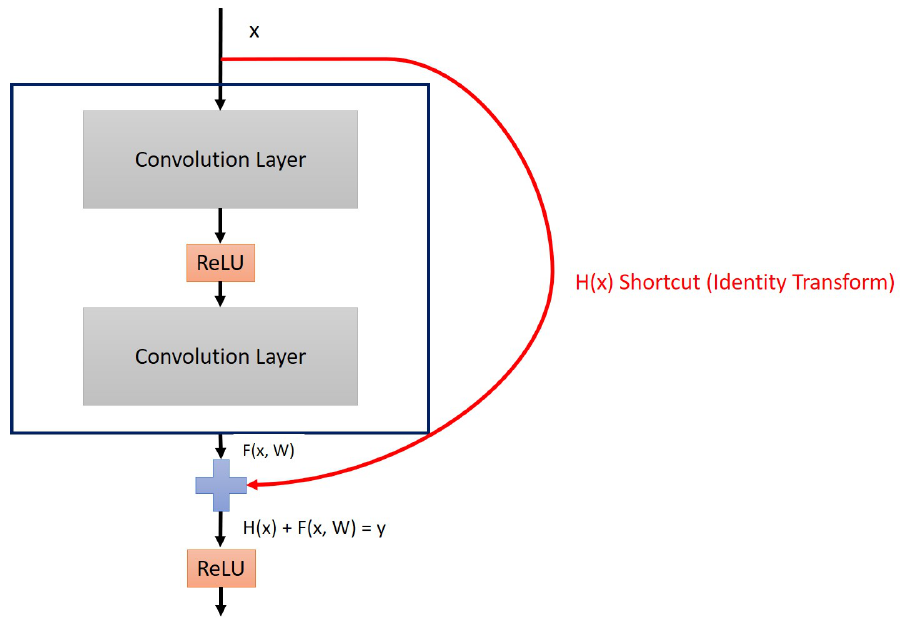
Figure 4. The residual block in